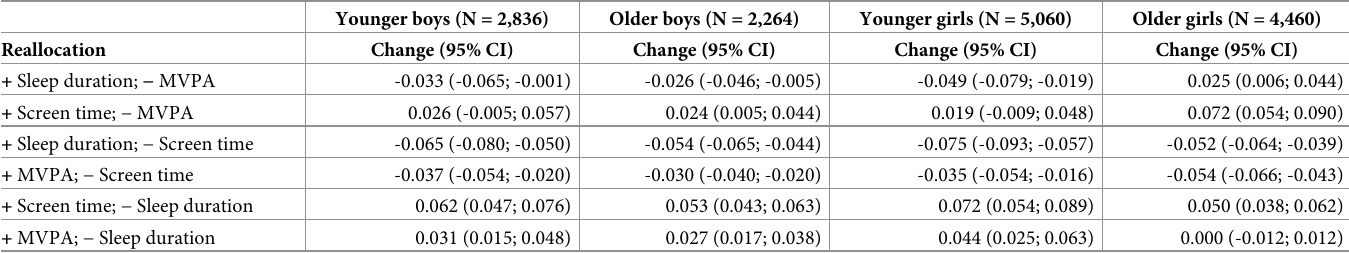
Table 4. Estimated changes in follow-up depressive symptoms associated with 60-minute reallocations from the mean baseline movement behaviour composition �